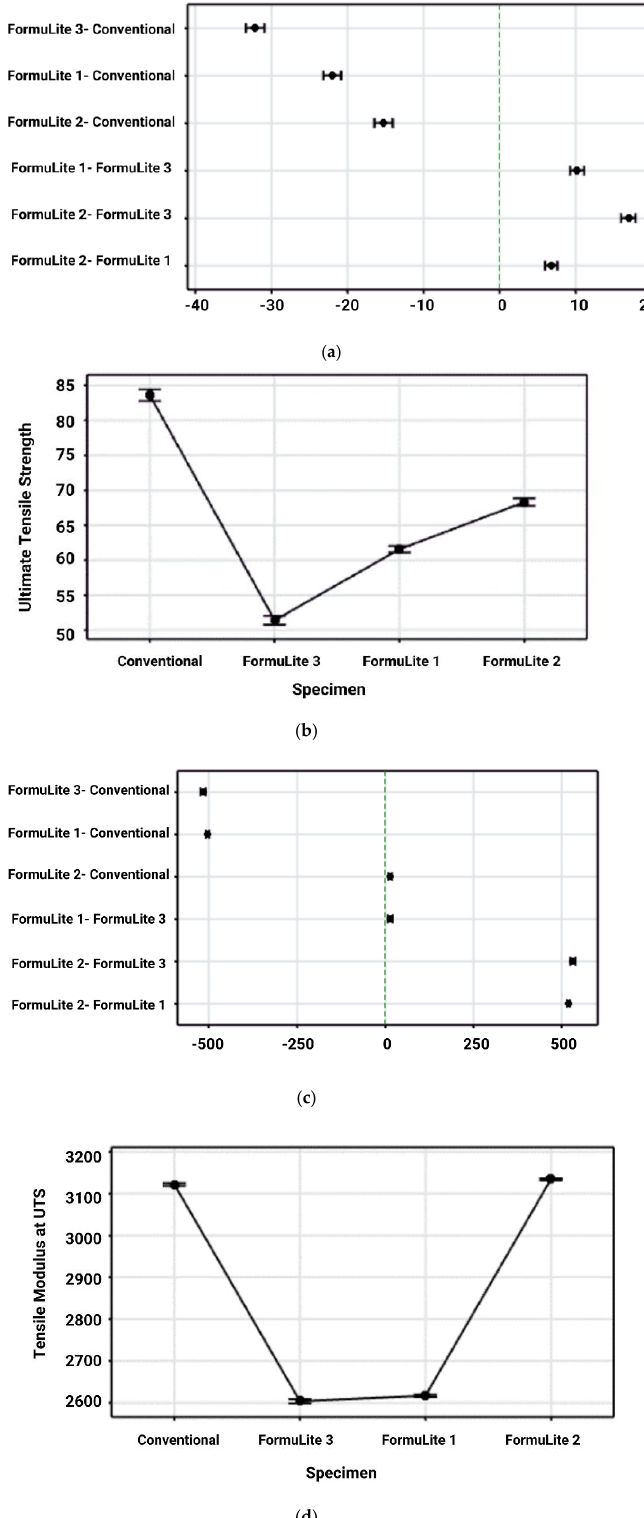
Figure 9. ( a ) Differences of means for ultimate tensile strength as per the ANOVA with Games–Howell comparison. ( b ) Interval plots of ultimate tensile strength versus epoxy/hardener specimens. ( c ) Differences of means for tensile modulus as per the ANOVA with Games–Howell comparison. ( d ) Interval plots of means of tensile modulus versus test